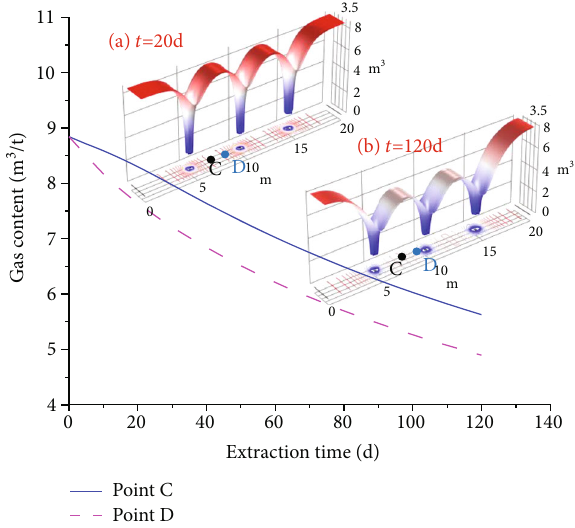
Figure 15: Variation of gas content with time when borehole diameter is 200 mm.